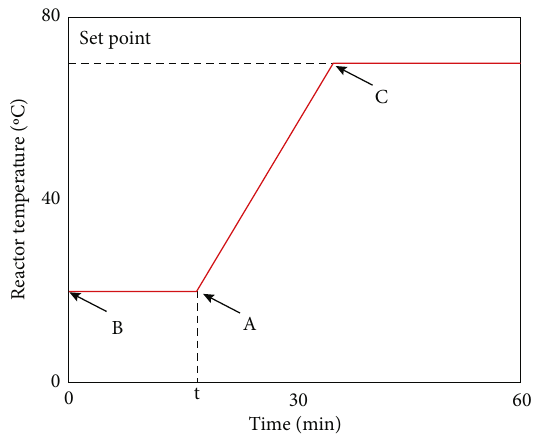
Figure 3: Three types of catalyst injection methods: (a) nonisothermal prepolymerization with a catalyst injection at room temperature, (b) isothermal prepolymerization with a catalyst injection at low temperature and keep in this temperature for time t , and (c) isothermal prepolymerization with a catalyst injection at set temperature. Table 1: Conditions for polymerization parallel experiments. Exp.